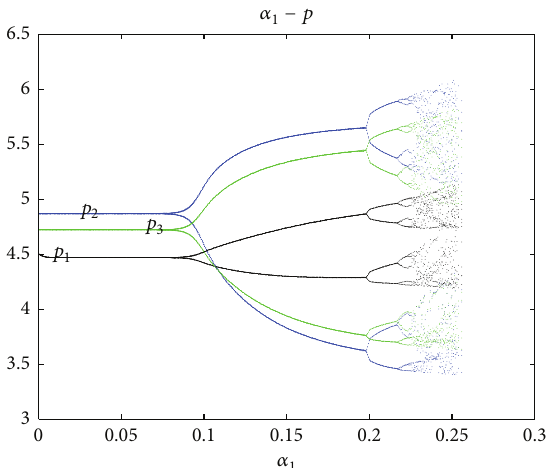
Figure 3: Price bifurcation with the change of 𝛼 1 .